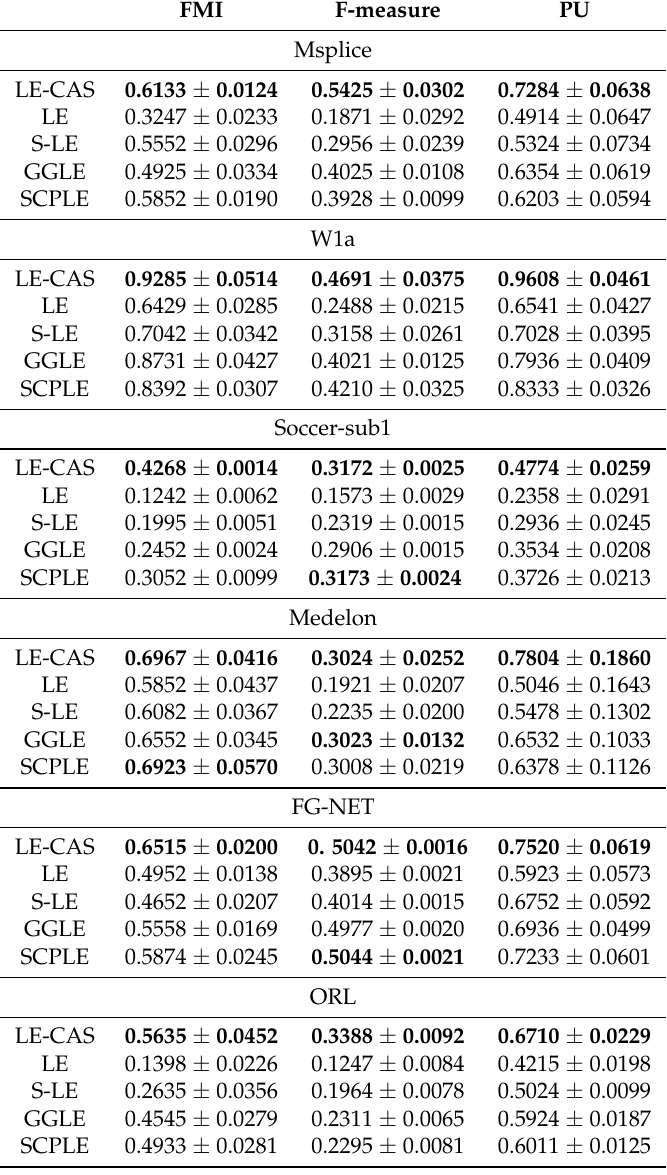
Table 2. Results (average ± std) of comparing methods on different datasets (Msplice, W1a, Soccer-sub1, Medelon, FG-NET, ORL, Musk, CNAE-9, SECOM, DrivFace). The target dimensionality c is set to 10. The best (or comparable to the best) results are in boldface